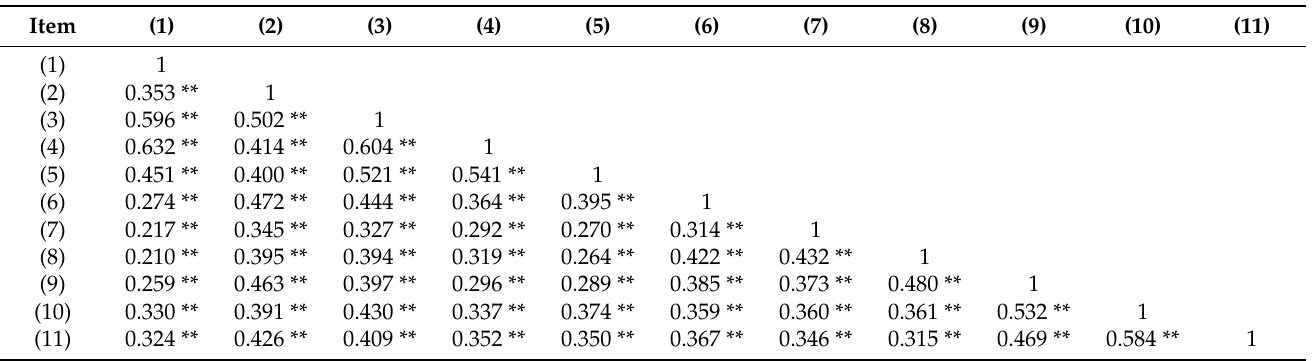
Table 3. Pearson’s correlations among the 11 gender role